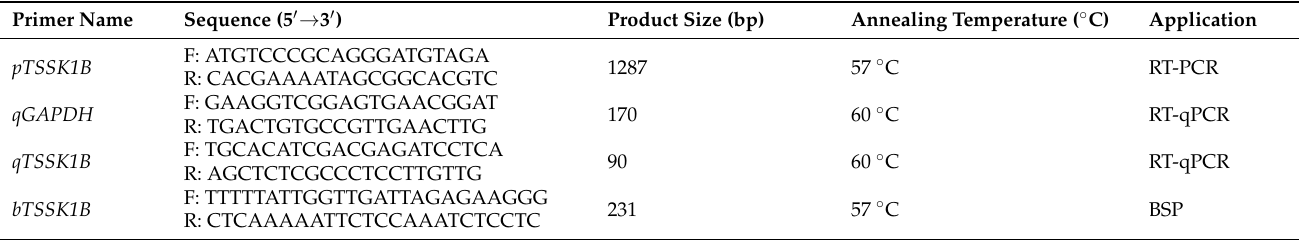
Table 1. The primers for TSSK1B